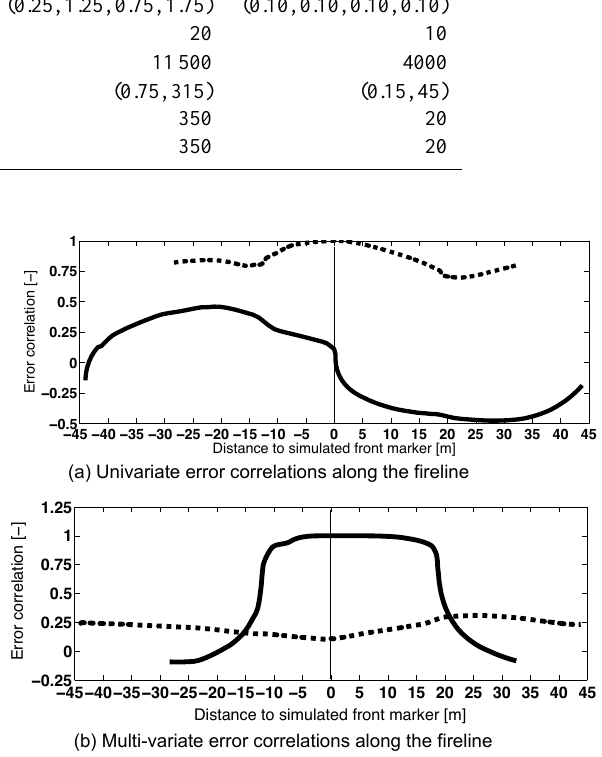
Table 2. Properties of the ensemble forecast in the OSSE anisotropic case. Random variable